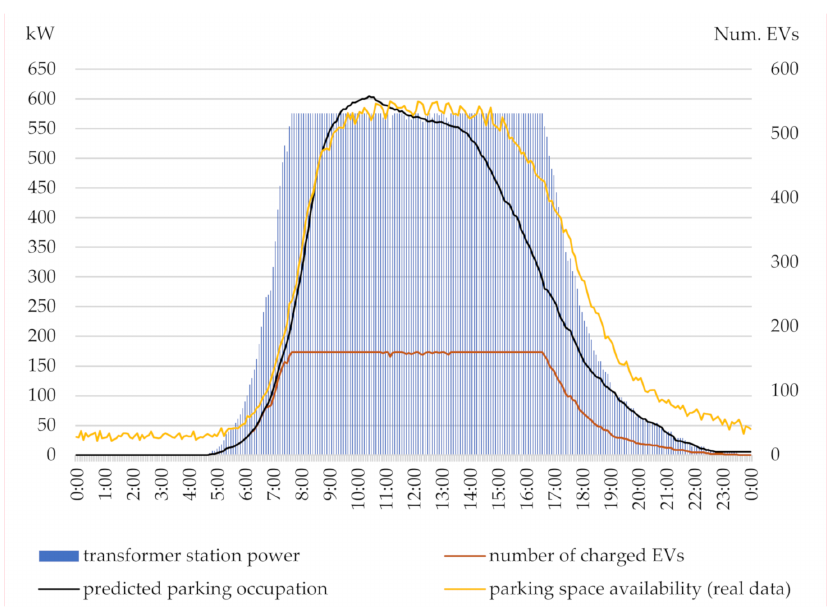
Figure 10. Modelled occupancy in the case of using one transformer.